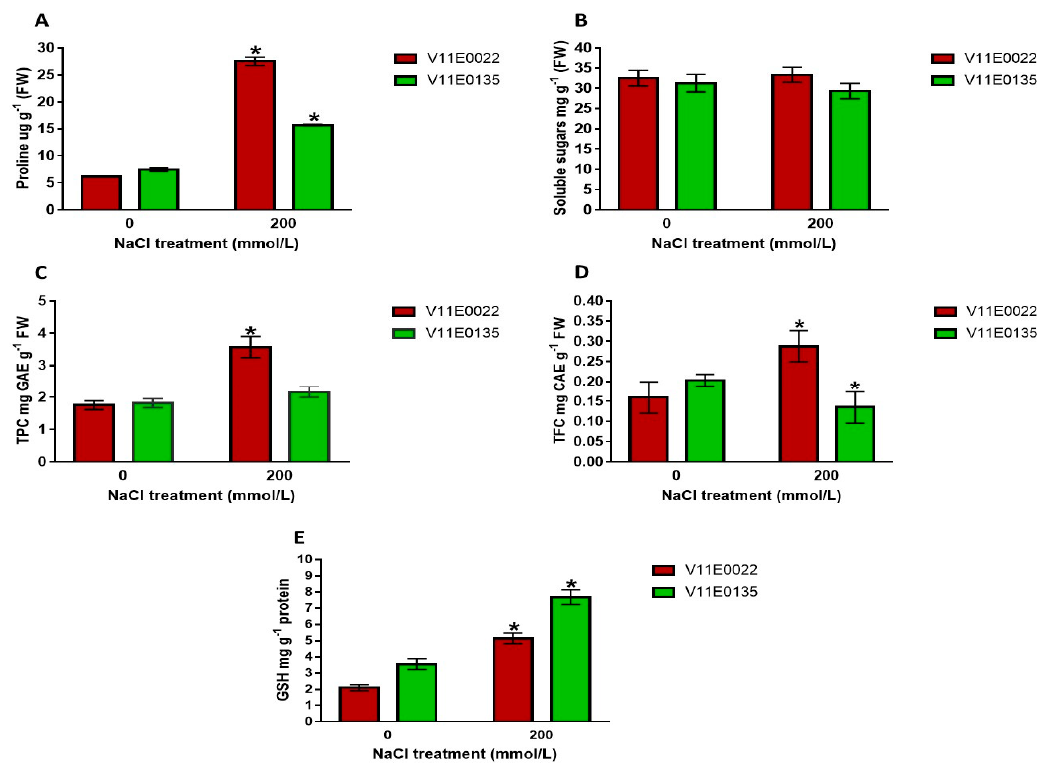
Figure 4. Effect of salt stress on the osmolytes and antioxidant molecules. ( A ) Content of proline, ( B ) content of soluble sugars, ( C ) total polyphenols compounds, ( D ) total flavonoids content, and ( E ) glutathione content in the water dropwort cultivars. Bars with the asterisks (*) indicate the significant difference ( p < 0.05) between the control and its respective treated samples. Values are means ± SD.